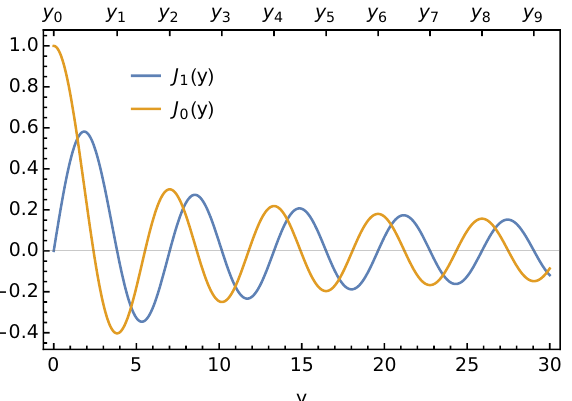
Figure 2. The Bessel function of the first kind and first order J 1 ( y ) and the Bessel function of the first kind and zeroth order J 0 ( y ) . The y n ’s indicate the solutions of J 1 ( y n ) = 0 in increasing order starting with y 0 =